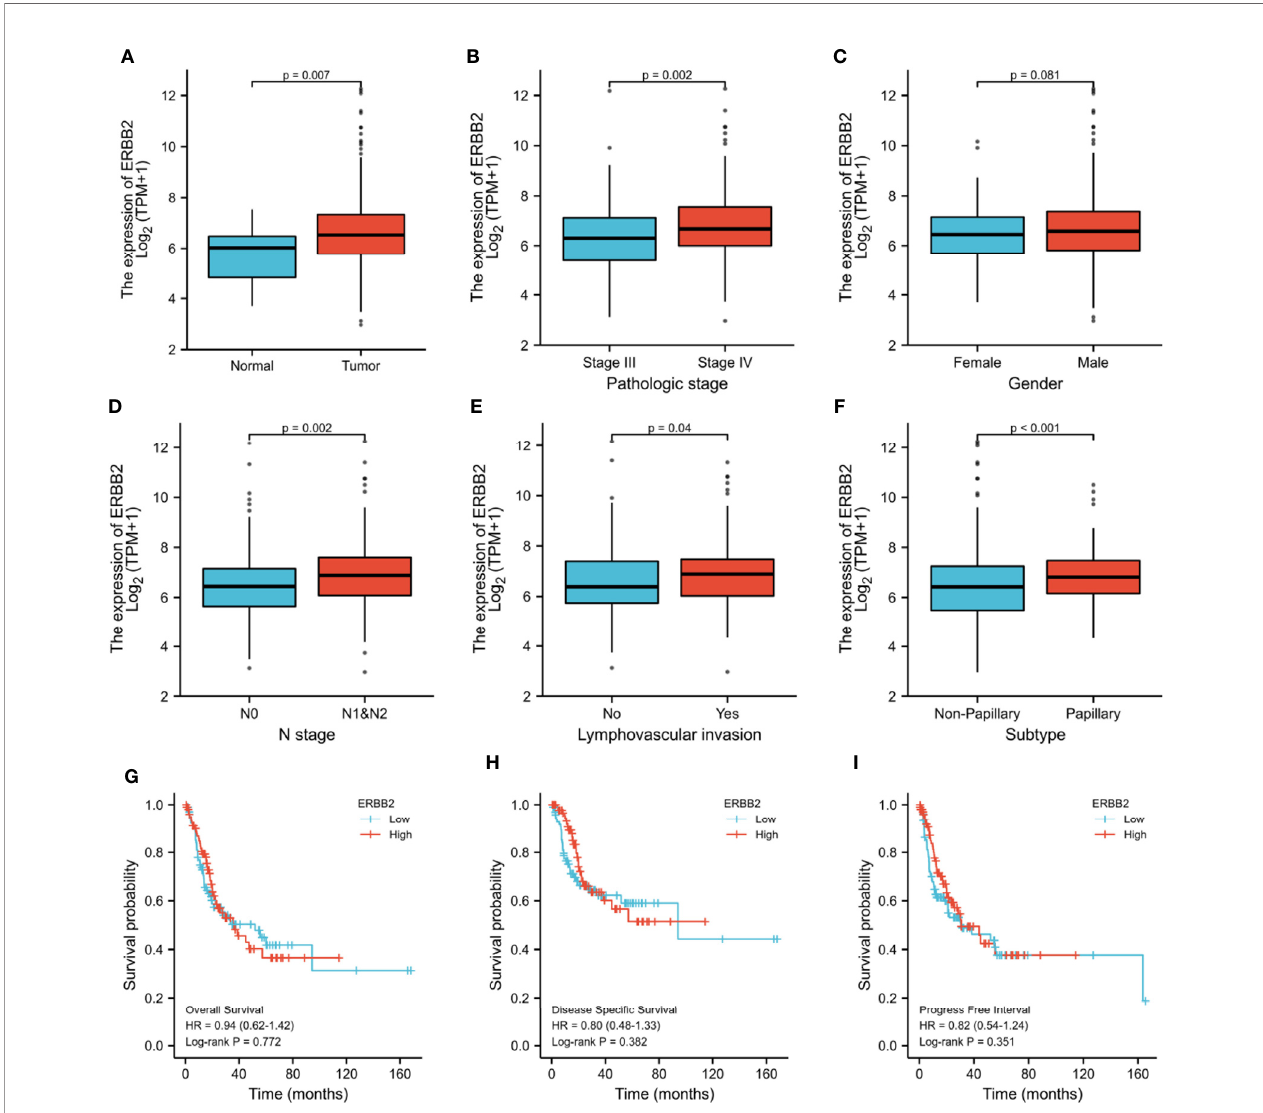
FIGURE 5 | TCGA analysis of differences about HER2 gene expression between cancer and normal tissues (A) , stage III and IV (B) , male and female (C) , N0 and N1&2 tumor (D) , LVI and no-LVI (E) and subtypes (F) . Survival conditions were also compared: overall survival (G) , disease speci fi c survival (H) and progress free interval (I) . ERBB2: HER2, Human Epidermal Growth Factor Receptor 2; LVI, lymph vascular invasion; HR, hazard